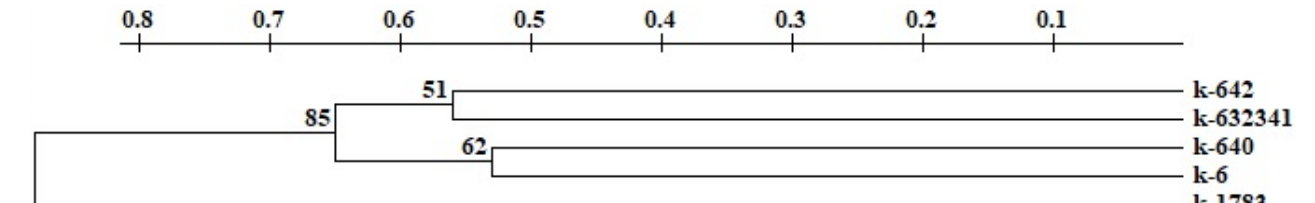
Figure 4. Dendrogram UPGMA (Unweighted Group Average or Unweighted Pair Group Method with Arithmetic Averaging), constructed on the basis of a comparative analysis of substances identified in V. unguiculata seeds.